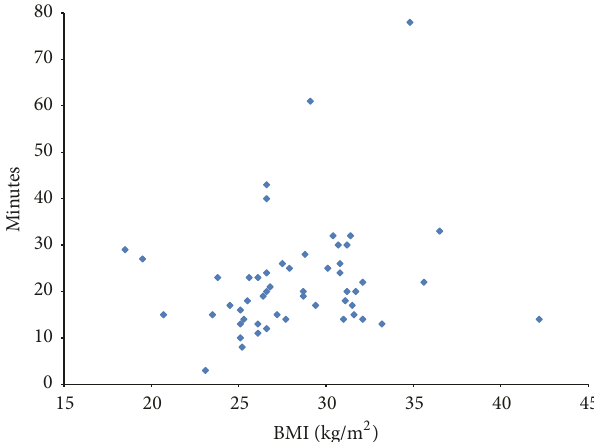
Figure 7: No correlation is identified between the fluoroscopy time and the body mass index.